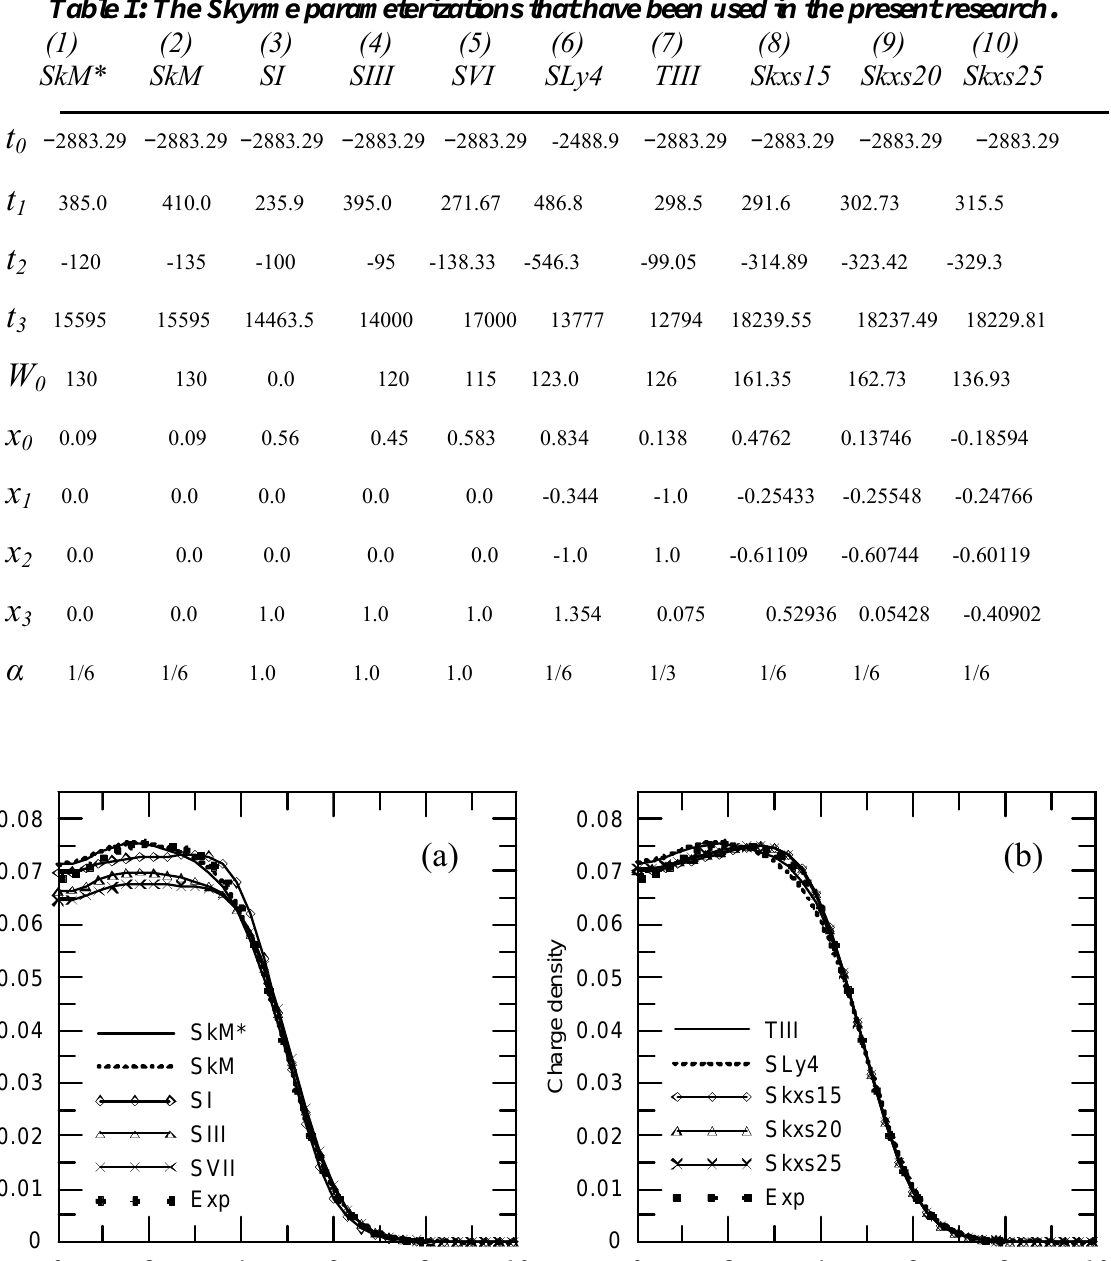
Table I: The Skyrme parameterizations that have been used in the present research.